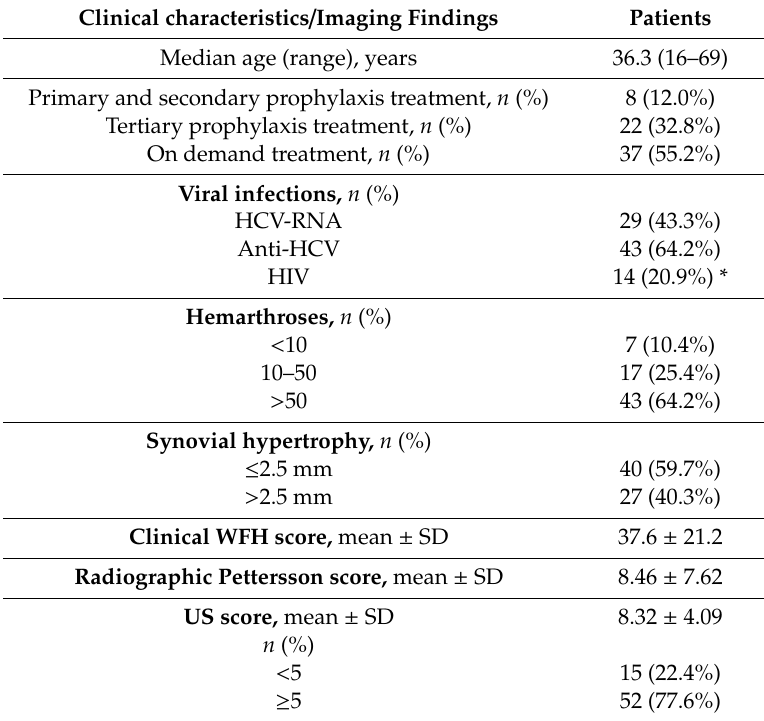
Table 1. Clinical characteristics and imaging findings of 67 hemophilia A patients. Clinical characteristics / Imaging Findings